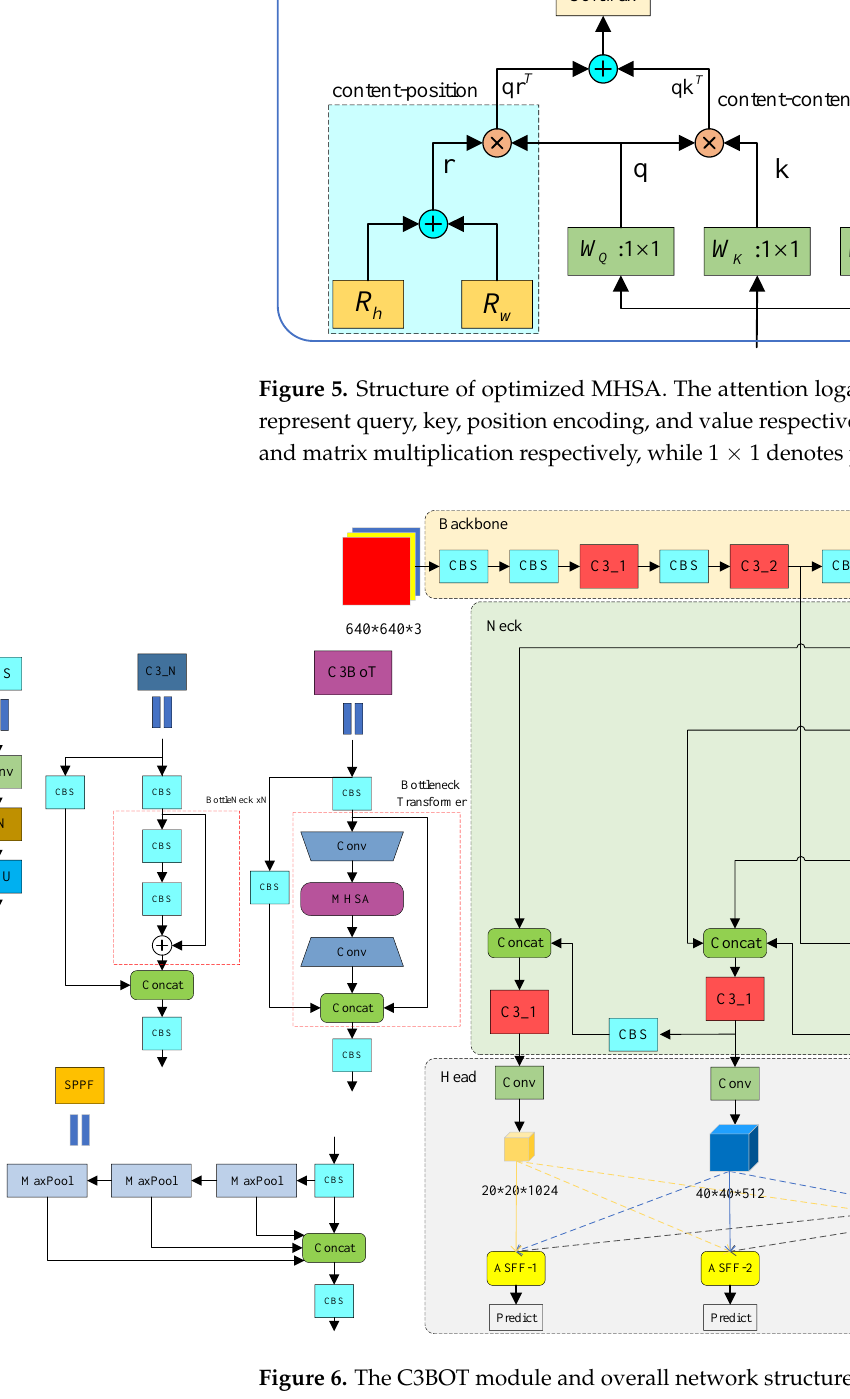
Figure 6. The C3BOT module and overall network structure of optimized YOLOv5s.